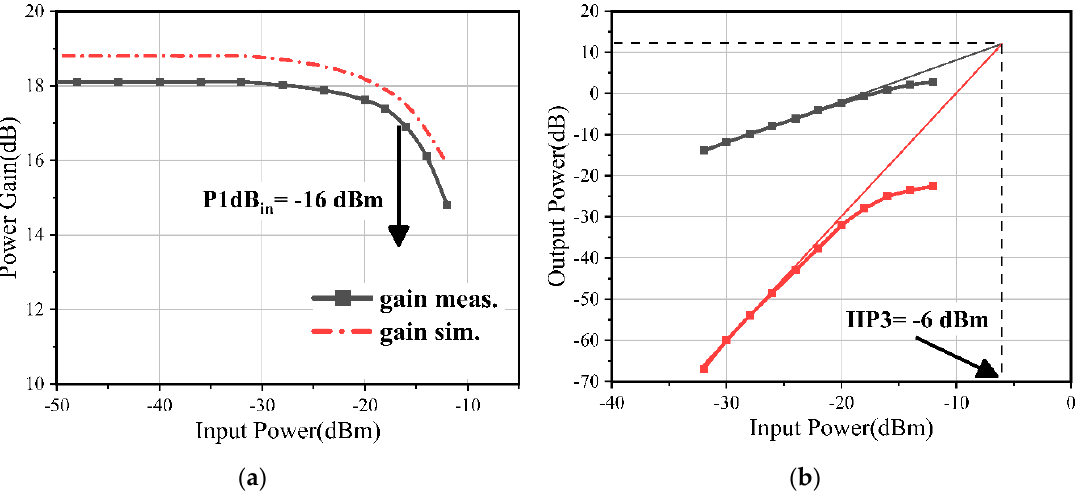
Figure 9. ( a ) P1dB of proposed LNA; ( b ) IIP3 of proposed LNA. Table 2. Performance comparison table.